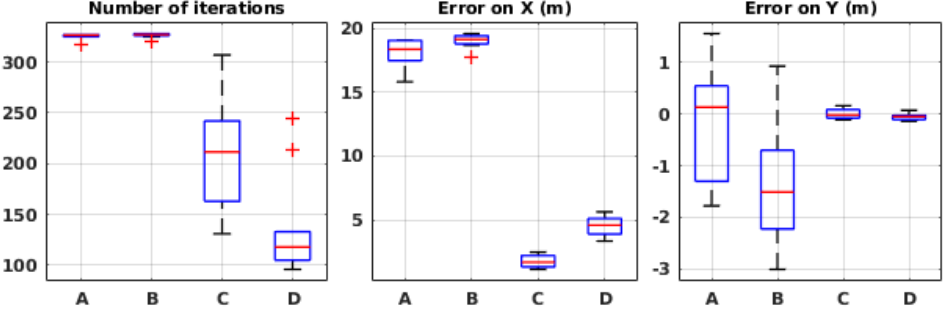
Figure 13. Evaluation results in simulation for different environmental conditions in the local framework. See Table 1 for the meaning of the labels.